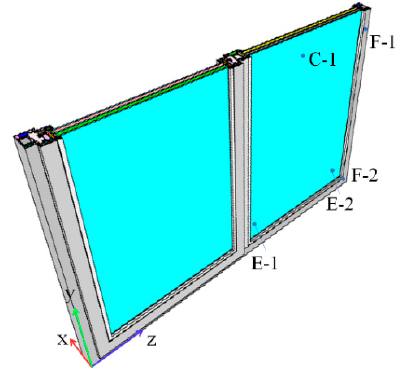
Figure 7. 3D Simulation model and temperature assessment points.